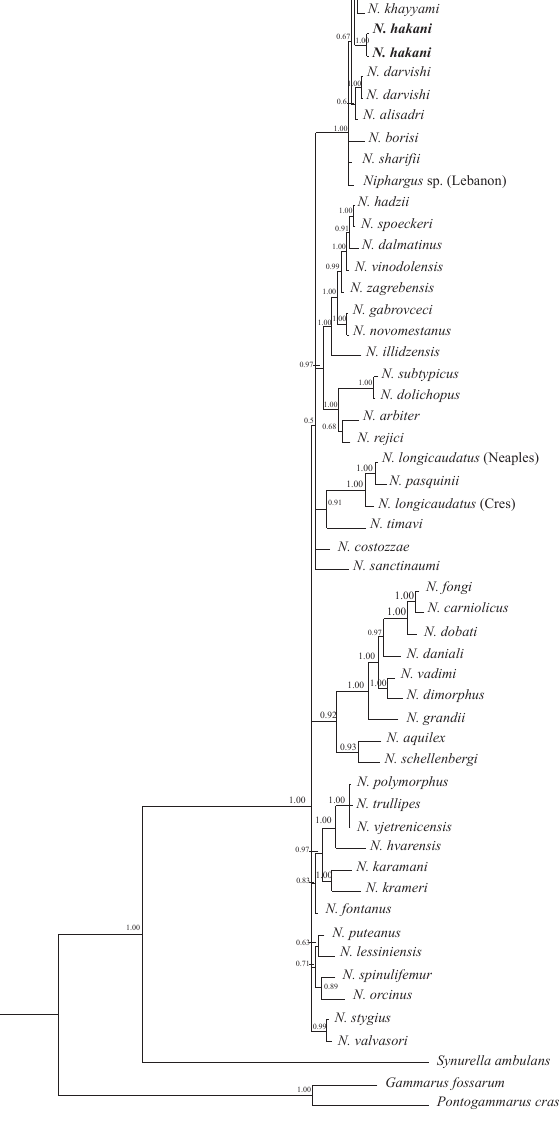
Figure 6. Bayesian consensus tree of 49 Niphargus species (48 taxa from Esmaeili-Rineh et al . 2015a, 2016), based on the 28S ribosomal DNA sequences. Species are identified and named according to the valid taxonomic description. Posterior probabilities are indicated on main